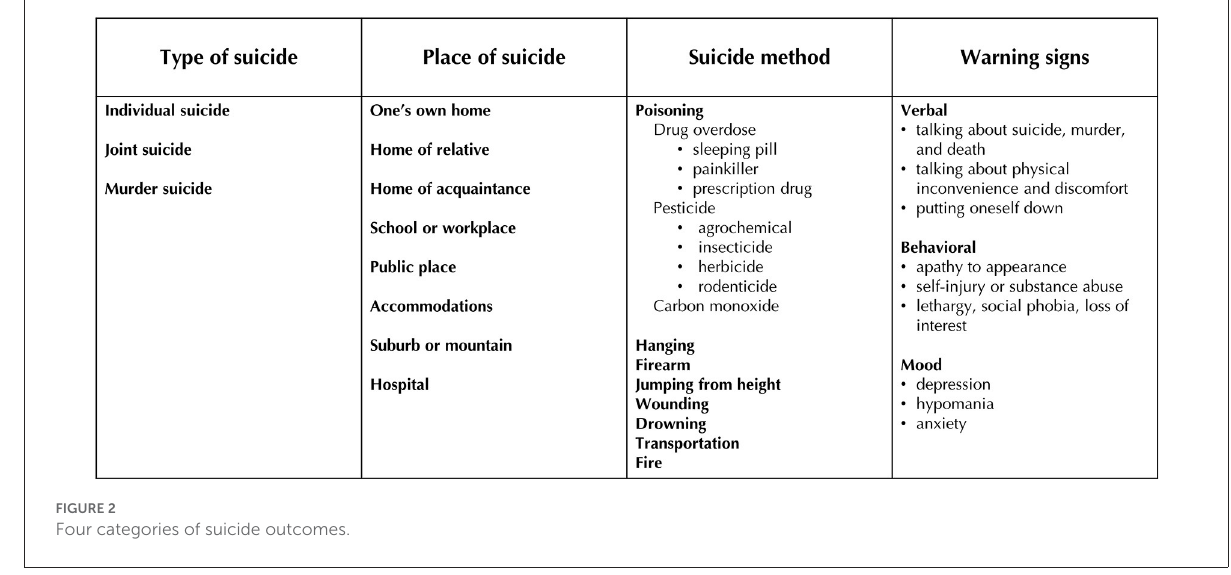
FIGURE2 Four categories of suicide outcomes.